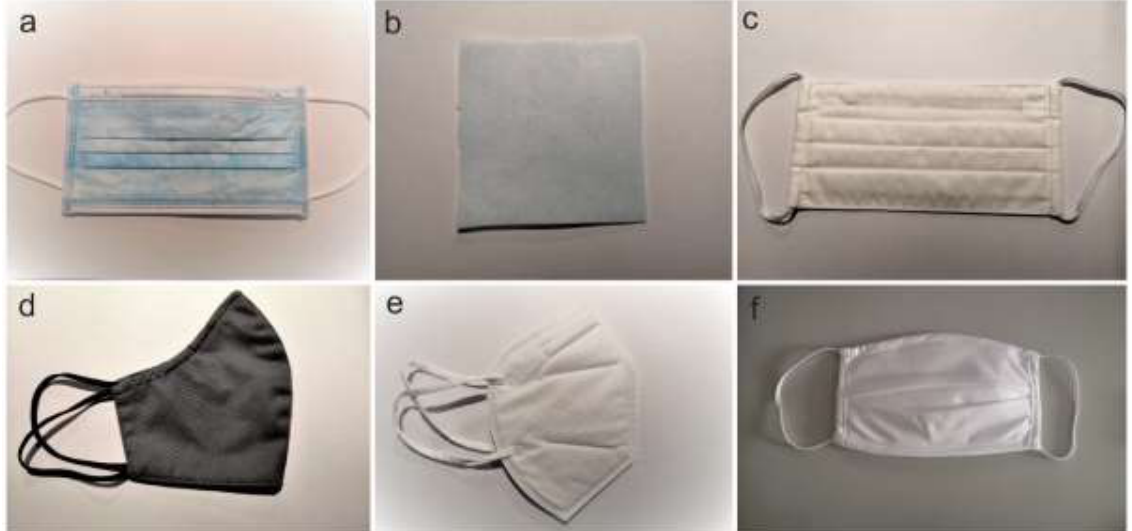
Figure 1. Six different mask samples were used for assessment of different experimental setups used for VFE and BFE tests: mask sample A was a three-layer polypropylene surgical mask classified as Type II, according to the standard EN 14683:2019+AC:2019 ( a ), mask sample B was a three–layer polypropylene material for mask production ( b ), mask samples C and F were reusable two-layer masks made only of woven cotton ( c , f ), mask sample D was a reusable mask made of woven cotton, polyester (outer layer), and polypropylene (inner layer) ( d ), whereas masks sample E was a five-layer respirator, classified as FFP2 according to EN 149:2001+A1:2009, made of nonwoven, meltblown, and cotton fabric ( e